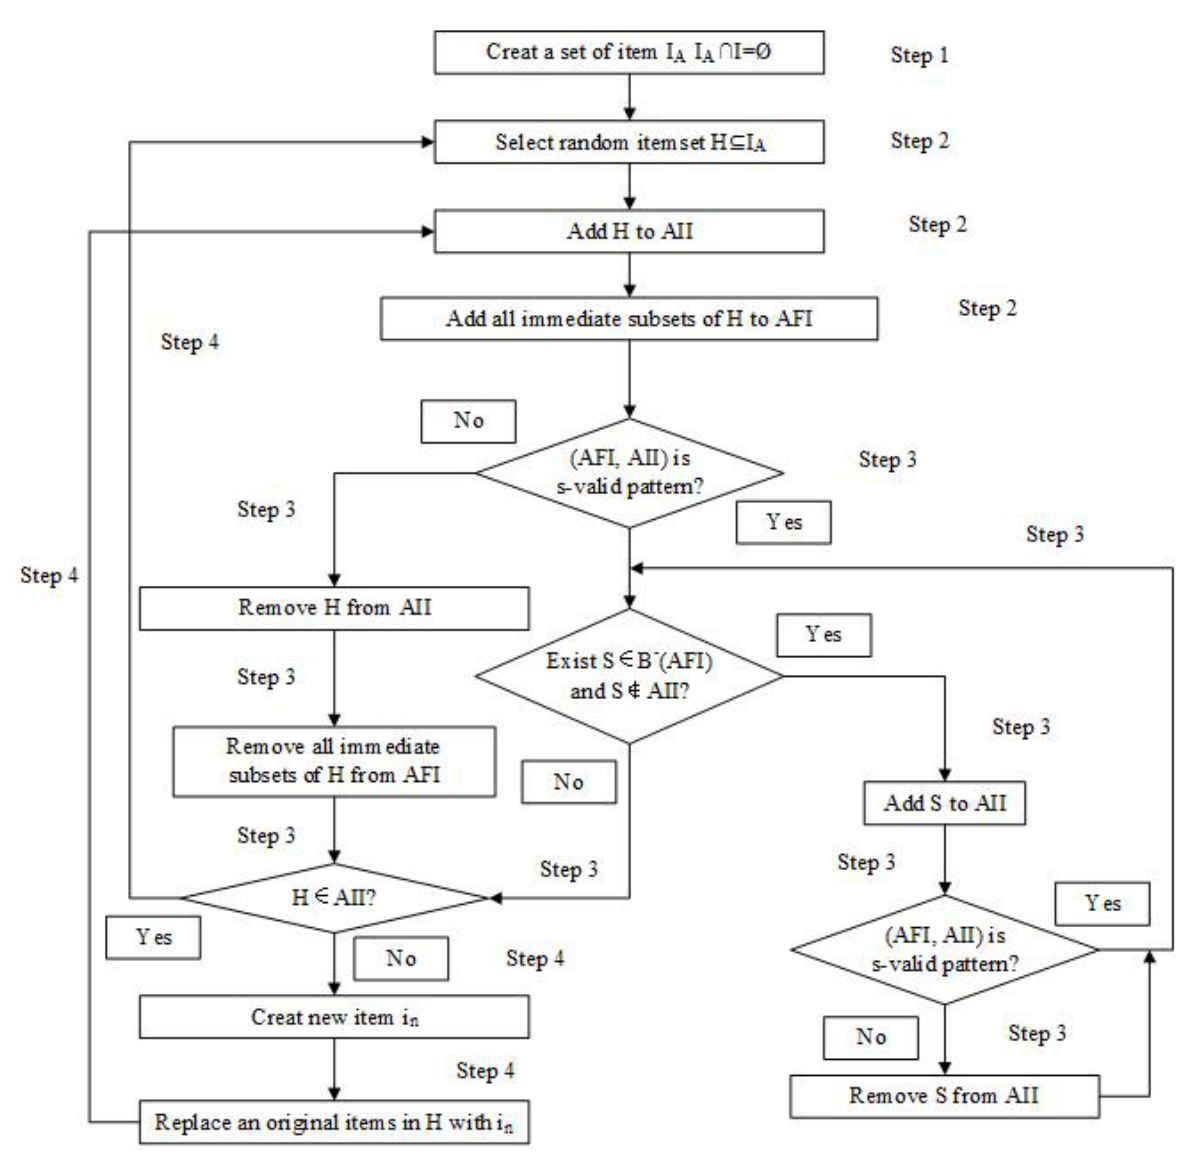
Figure 2. Artificial Itemset